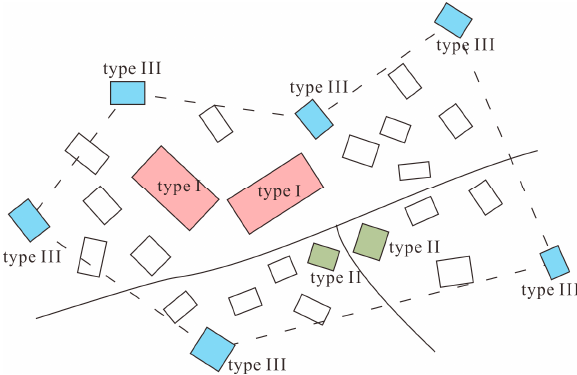
Figure 5. Three types of structurally important buildings.